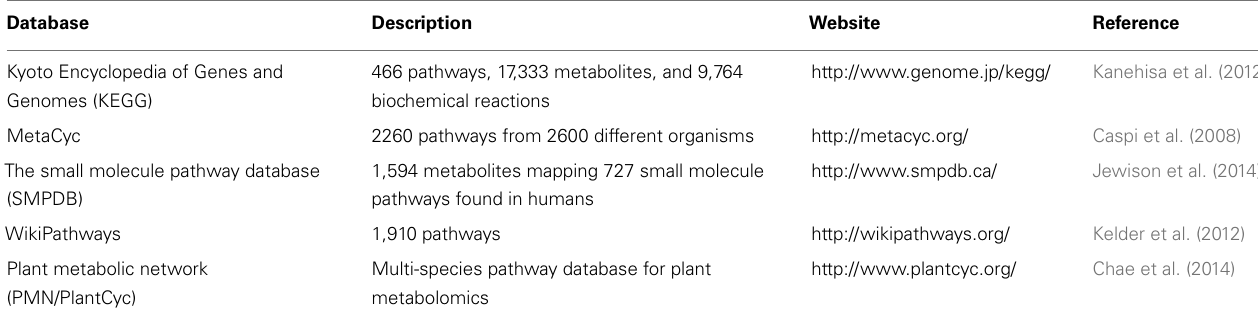
Table 3 | Biological databases for pathway analysis